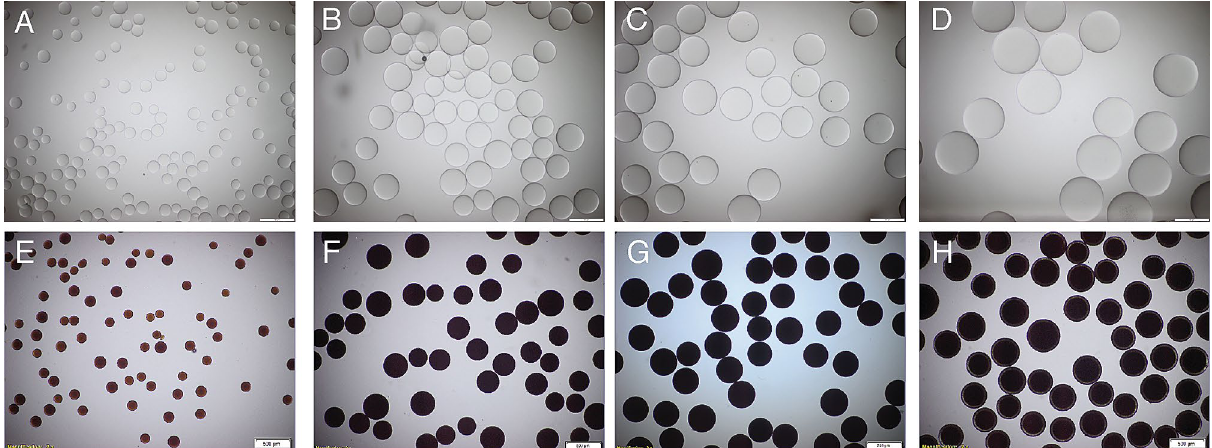
Figure 2. Light microscopy of beads. Size and appearance of different size of blank beads ( A – D ) and bismuth- functionalized beads ( 7 ) ( E–H ) under light microscopy, ( A , E ) 100–160 μm, ( B , F ) 250–355 μm, ( C , G ) 355–425 μm and ( D , H ) 425–600